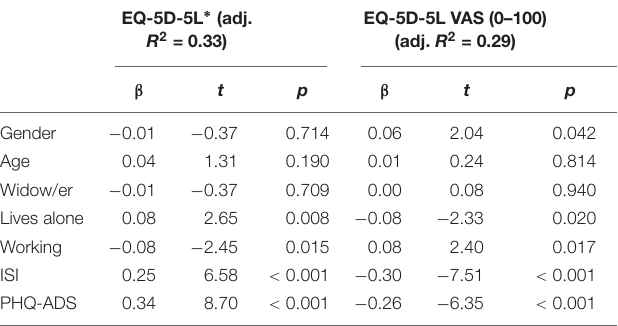
TABLE 6 | Predictors of health-related quality of